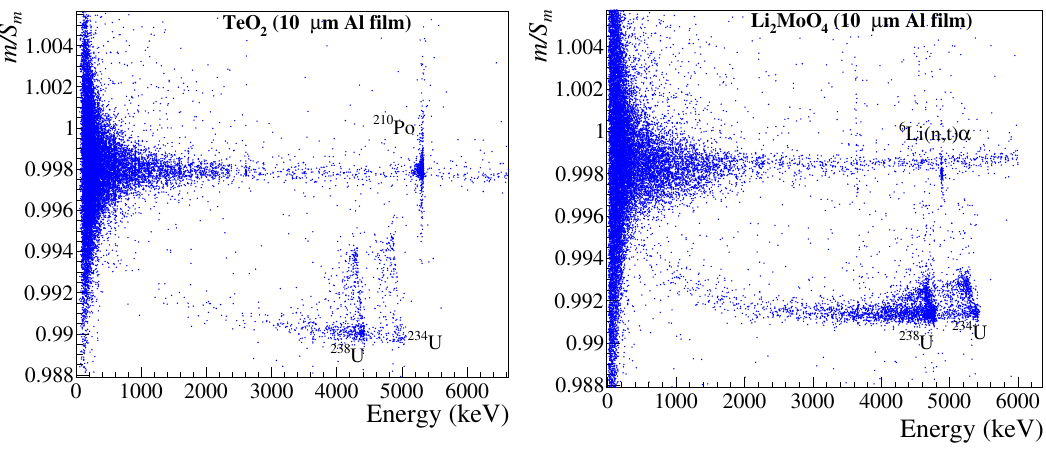
Figure 4 . The parameter m=S m (see text) is plotted as a function of the energy (according to a (cid:13) calibration) for a TeO 2 bolometer (Detector 2 in table 1) (left panel) and for a Li 2 MoO 4 bolometer (Detector 1 in table 1) (right panel). The uranium-source (cid:11) events are clearly discriminated. The main features of the plots are discussed in the text. In particular, the neutron capture events on 6 Li are discussed in section 3.3, while the shape of the populations related to the uranium (cid:11) particles is discussed in section